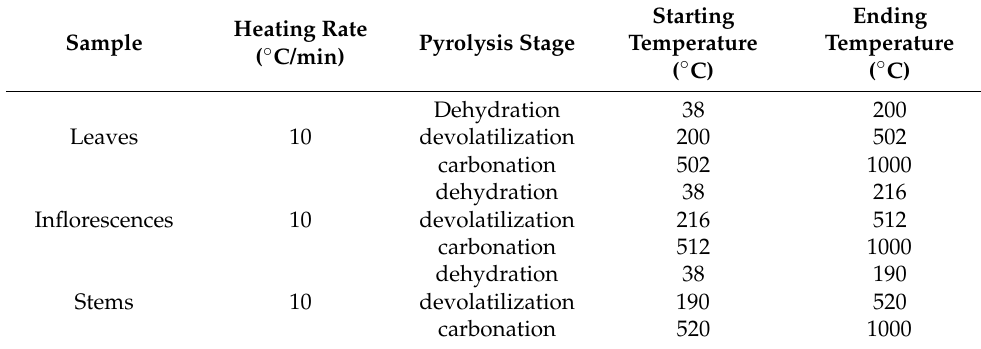
Table 2. Main stages of thermal